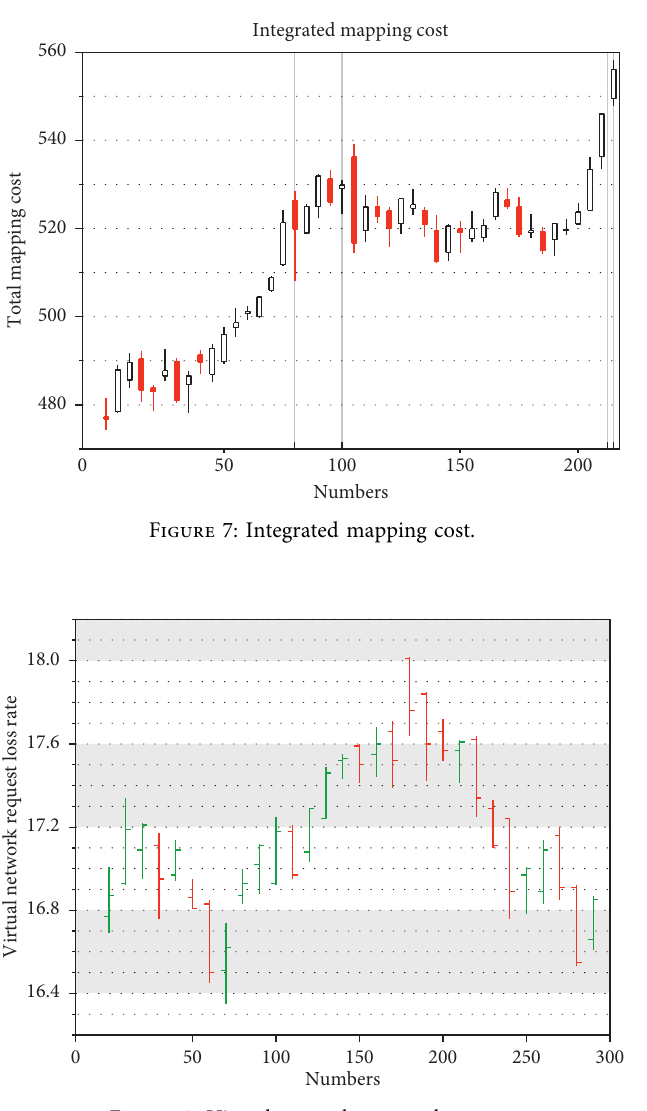
Figure 8: Virtual network request loss